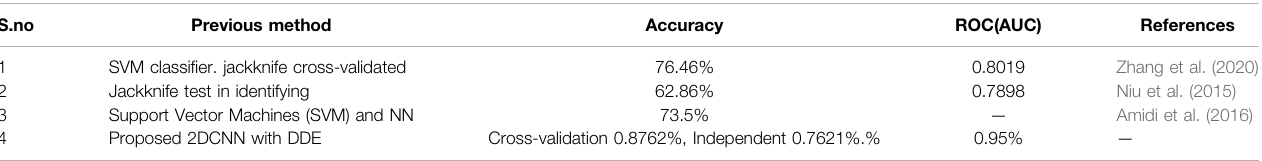
TABLE 7 | Existing method comparison accuracy and